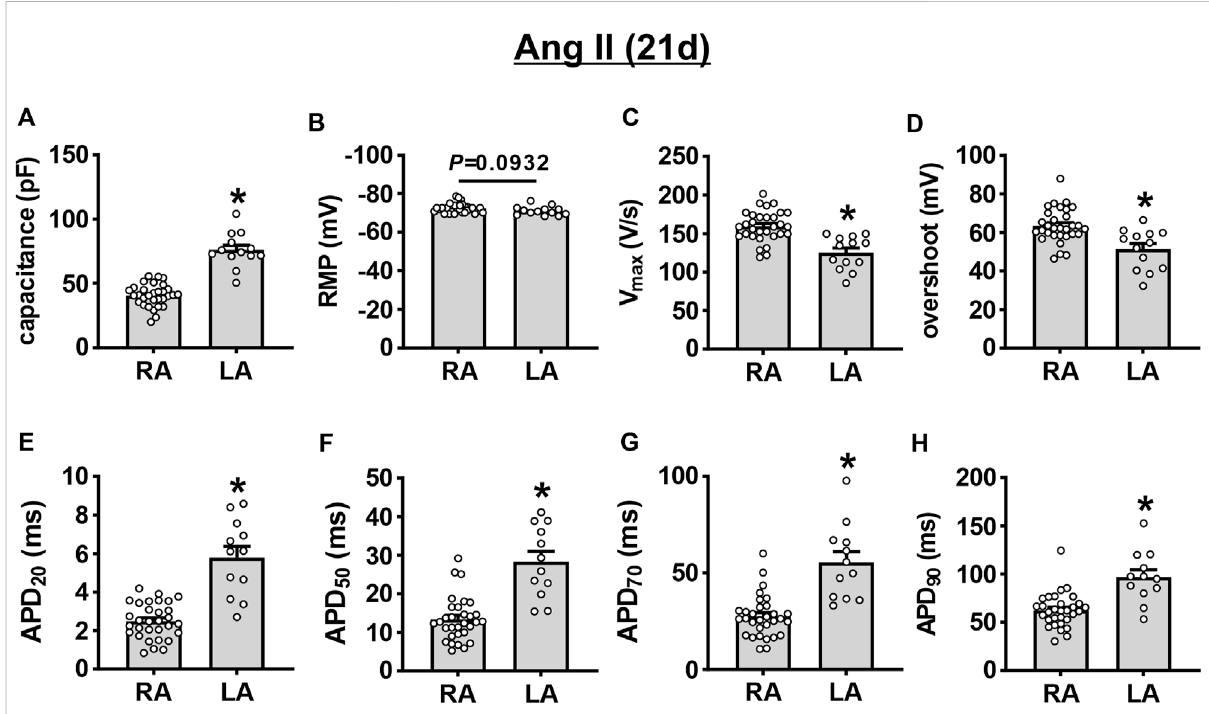
FIGURE 5 Comparison of action potential morphology in left and right atrial myocytes after 21 days of Ang II infusion. (A – H) Summary of cell capacitance (A) , RMP (B) , V max (C) , overshoot (D) , APD 20 (E) , APD 50 (F) , APD 70 (G) , and APD 90 (H) in mouse right (RA) and left (LA) atrial myocytes at 21 days of Ang II. * p < 0.05 vs RA by Student ’ s t -test; n =31 myocytes for RA and 13 myocytes for